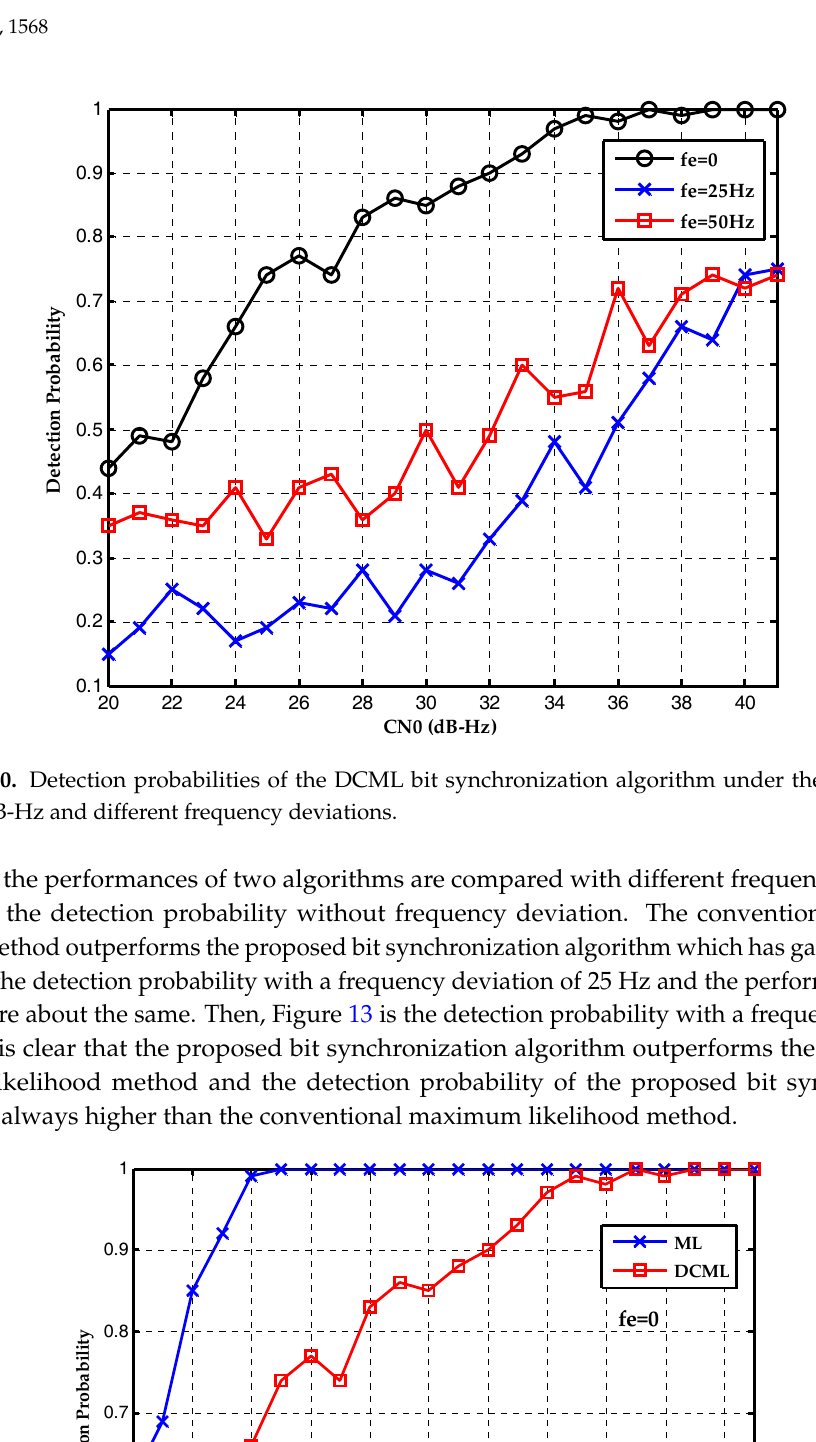
Figure 9. Detection probabilities of the ML bit synchronization algorithm under the CN0s of 20~40 dB-Hz and different frequency deviations.